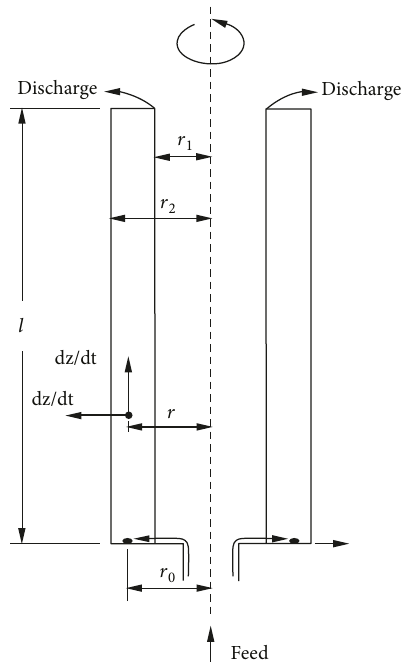
Figure 1: Schematic diagram of tube centrifuge